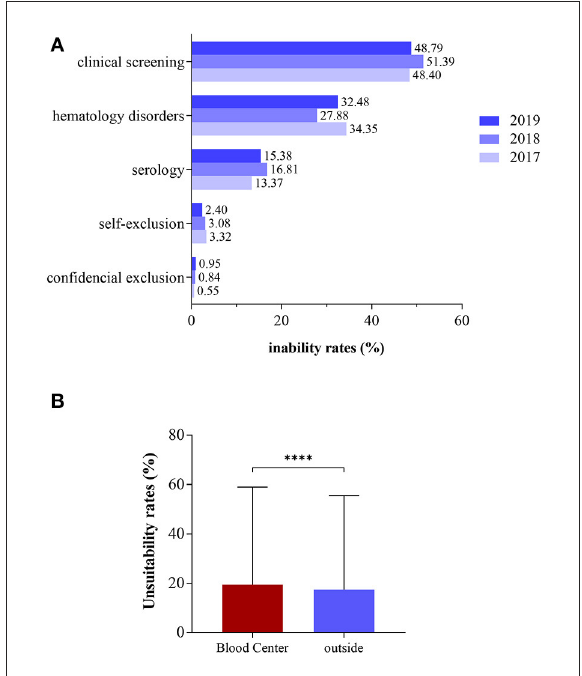
FIGURE2 Causes of unsuitability according to year (A) and place of donation (B) . **** p < 0.00001 (Student’s t